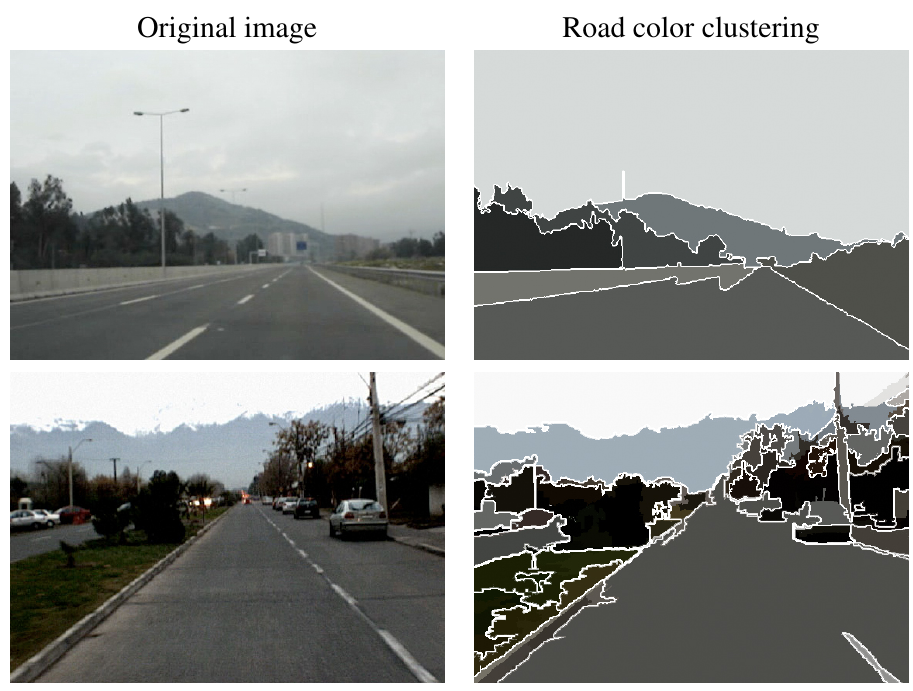
Figure 1. Example results from the mean-shift segmentation using bandwidth parameters h = 2 , h = 4 s r